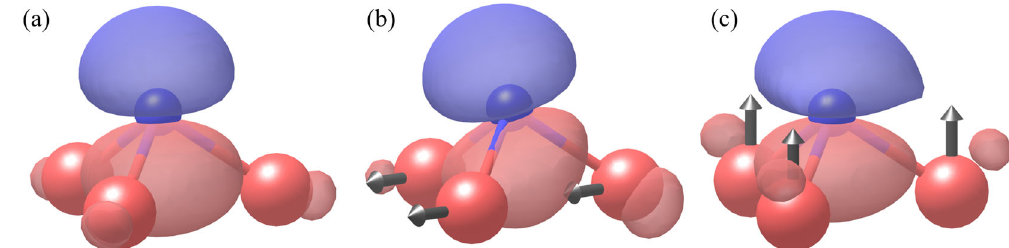
Fig. 3 Visualization of a sulfur p z maximally localized Wannier orbital. The blue atom is a sulfur center, whereas red atoms are bonded hafnium centers. The red and blue lobes of the orbital indicate the opposite signs of the wavefunction. No structural distortion is present in ( a ). Hf atoms are displaced in-plane and out-of-plane in ( b ) and ( c ),